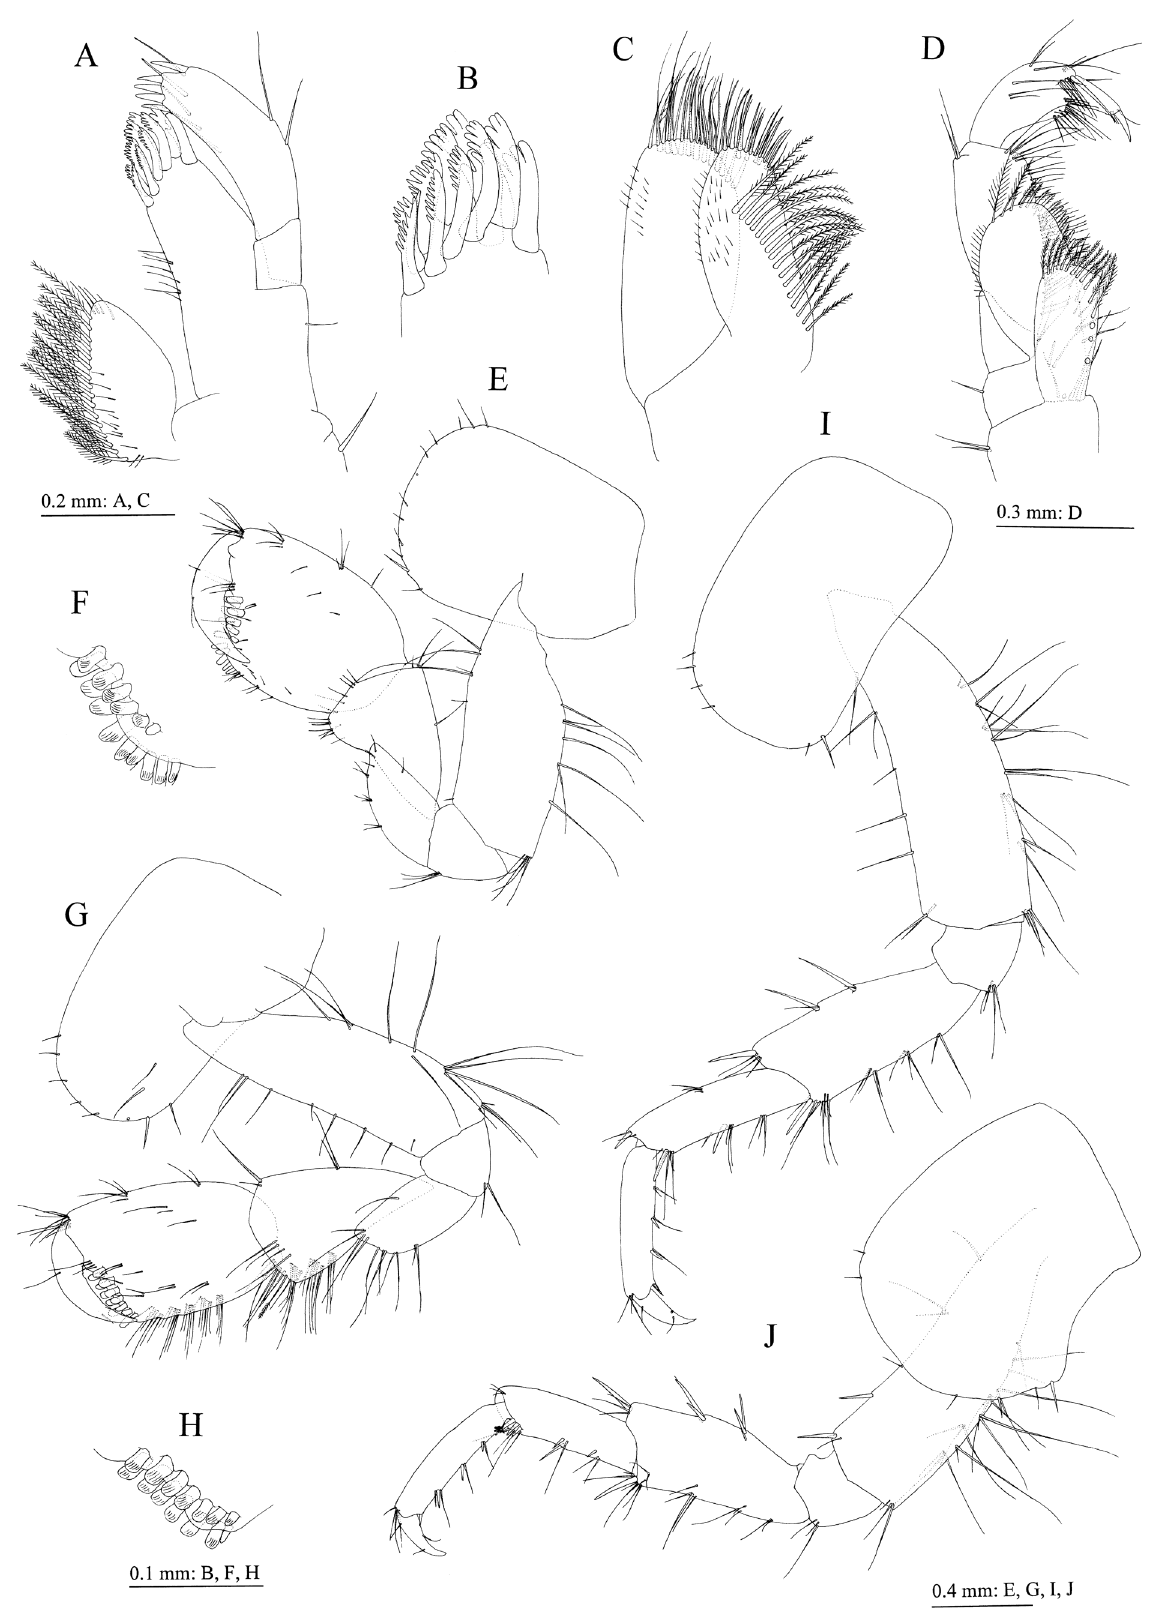
Figure 11. Jesogammarus uchiyamaryui sp. n., holotype, male (10.3 mm), NSMT-Cr 25474. A maxilla 1, dorsal view; B outer plate of maxilla 1, dorsal view; C maxilla 2, dorsal view; D maxilliped, dorsal view; E gnathopod 1, lateral view; F palmar margin of propodus of gnathopod 1, lateral view; G gnathopod 2, lateral view; H palmar margin of propodus of gnathopod 2, lateral view; I pereopod 3, lateral view; J pereopod 4, lateral